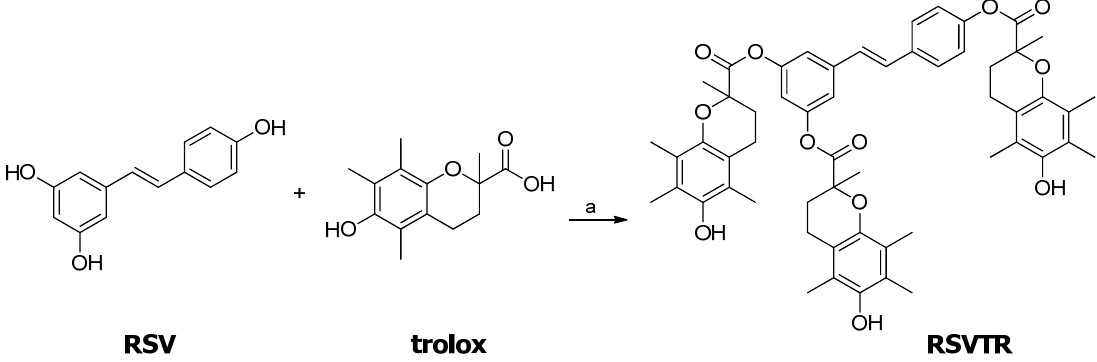
Figure 2. Synthesis of RSVTR. Reagents and conditions: (a) EDC · HCl, DMAP, dry DCM, 0 °C, then room temperature 8 h. RSVTR was purified by flash column chromatography using Merck silica gel (0.040– 0.063 mm). The infrared spectrum was recorded on a Perkin Elmer series FTIR 1600 spec-